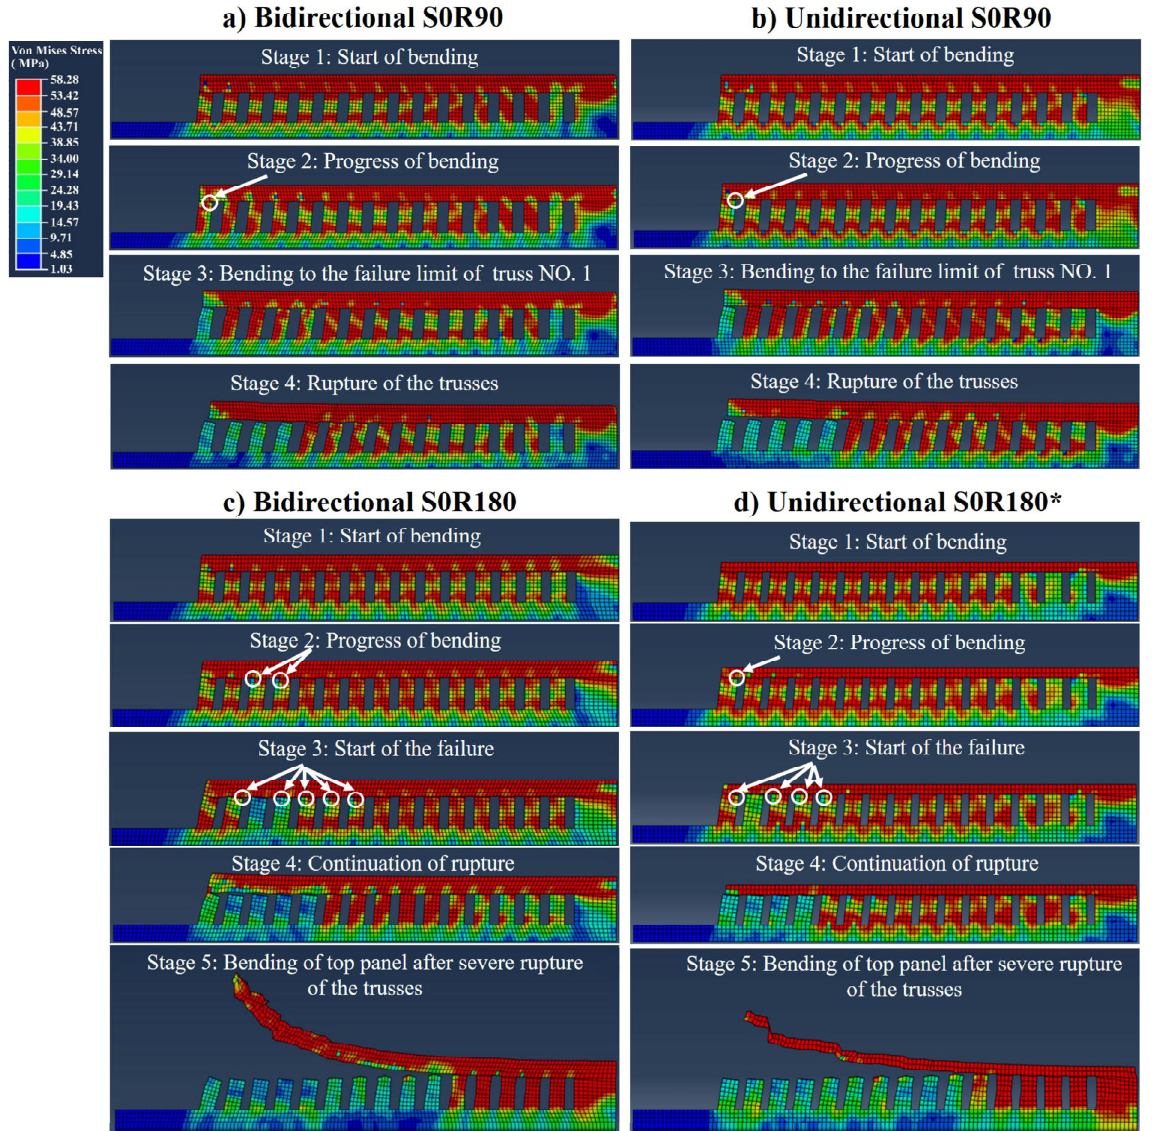
Figure 13. Stress simulated bending and rupturing of the trusses supporting ( a ) bidirectional and ( b ) unidirectional S0R90 panel as well as ( c ) bidirectional and ( d ) unidirectional S0R180 panel. Note that the unidirectional S0R180 part only had a panel thickness of 1.15 mm (instead of 2 mm) due to the process failure after excessive bending. For better visualization, see also the video provided in the supplementary data.